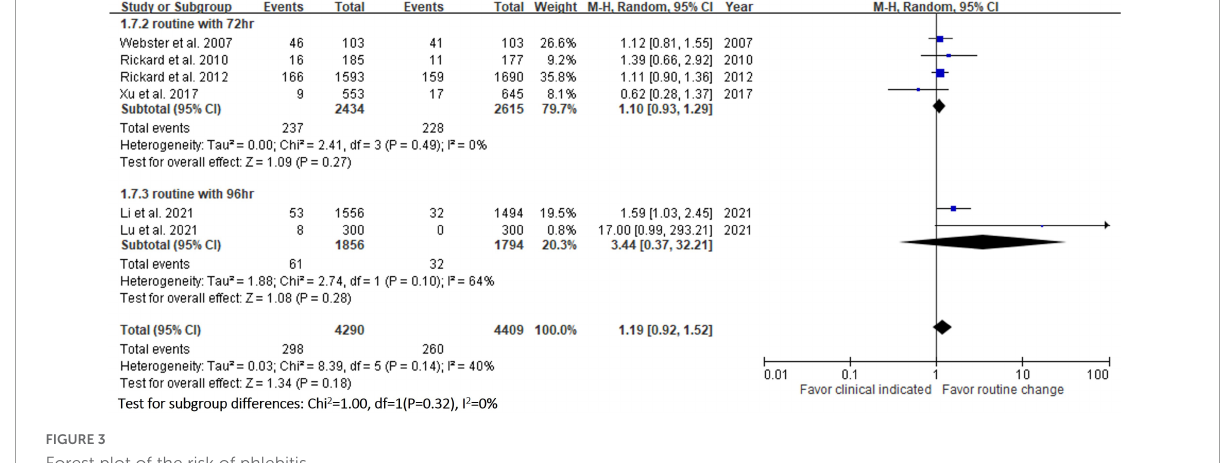
FIGURE3 Forest plot of the risk of phlebitis.